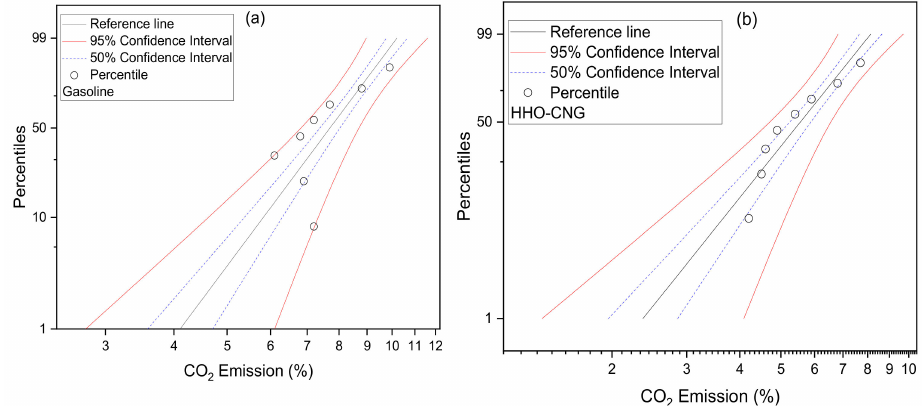
Figure 4. ( a ) CO 2 Weibull distributions for various CIs using gasoline and ( b ) CO 2 Weibull distribu- tions for various CIs using HHO–CNG.